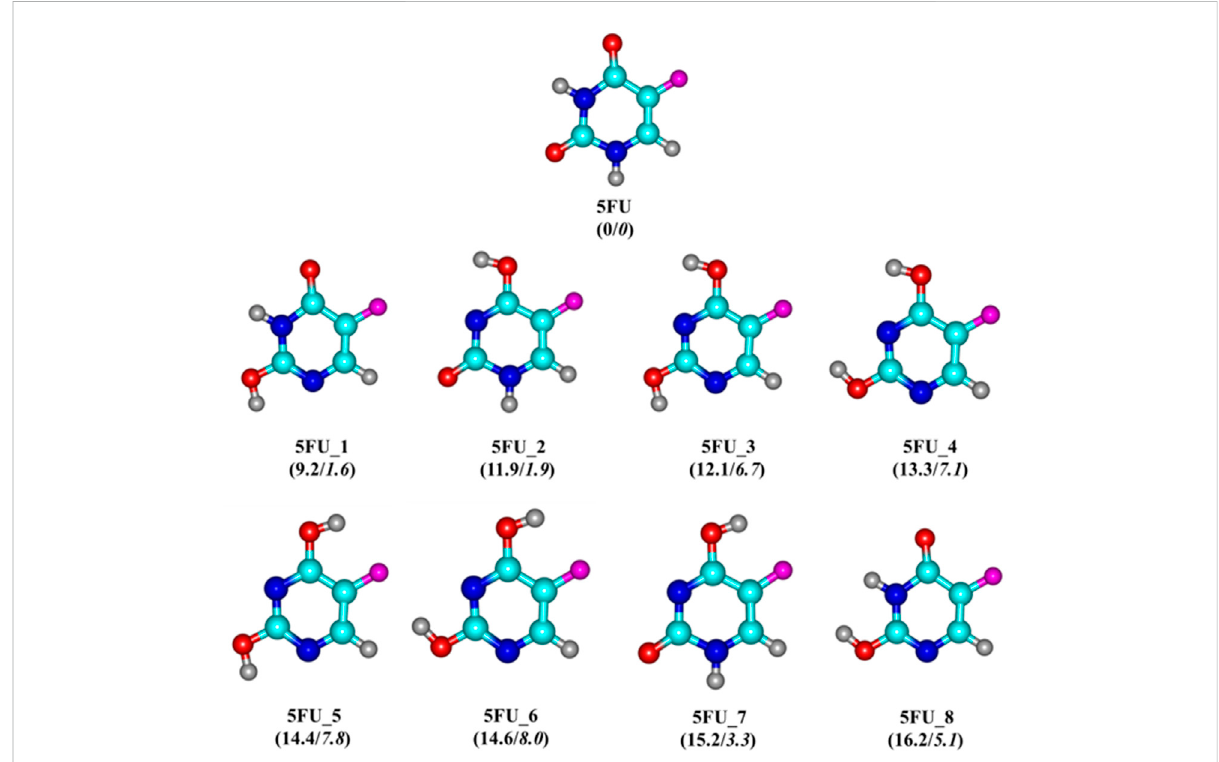
FIGURE 2 Optimized structures of 5FU and its tautomers.Values (kcal/mol) given in parentheses represent relative energiesof 5FU tautomers at thePBE- D3/cc-pVTZ + ZPE level in vacuum/water solution with respect to 5FU.